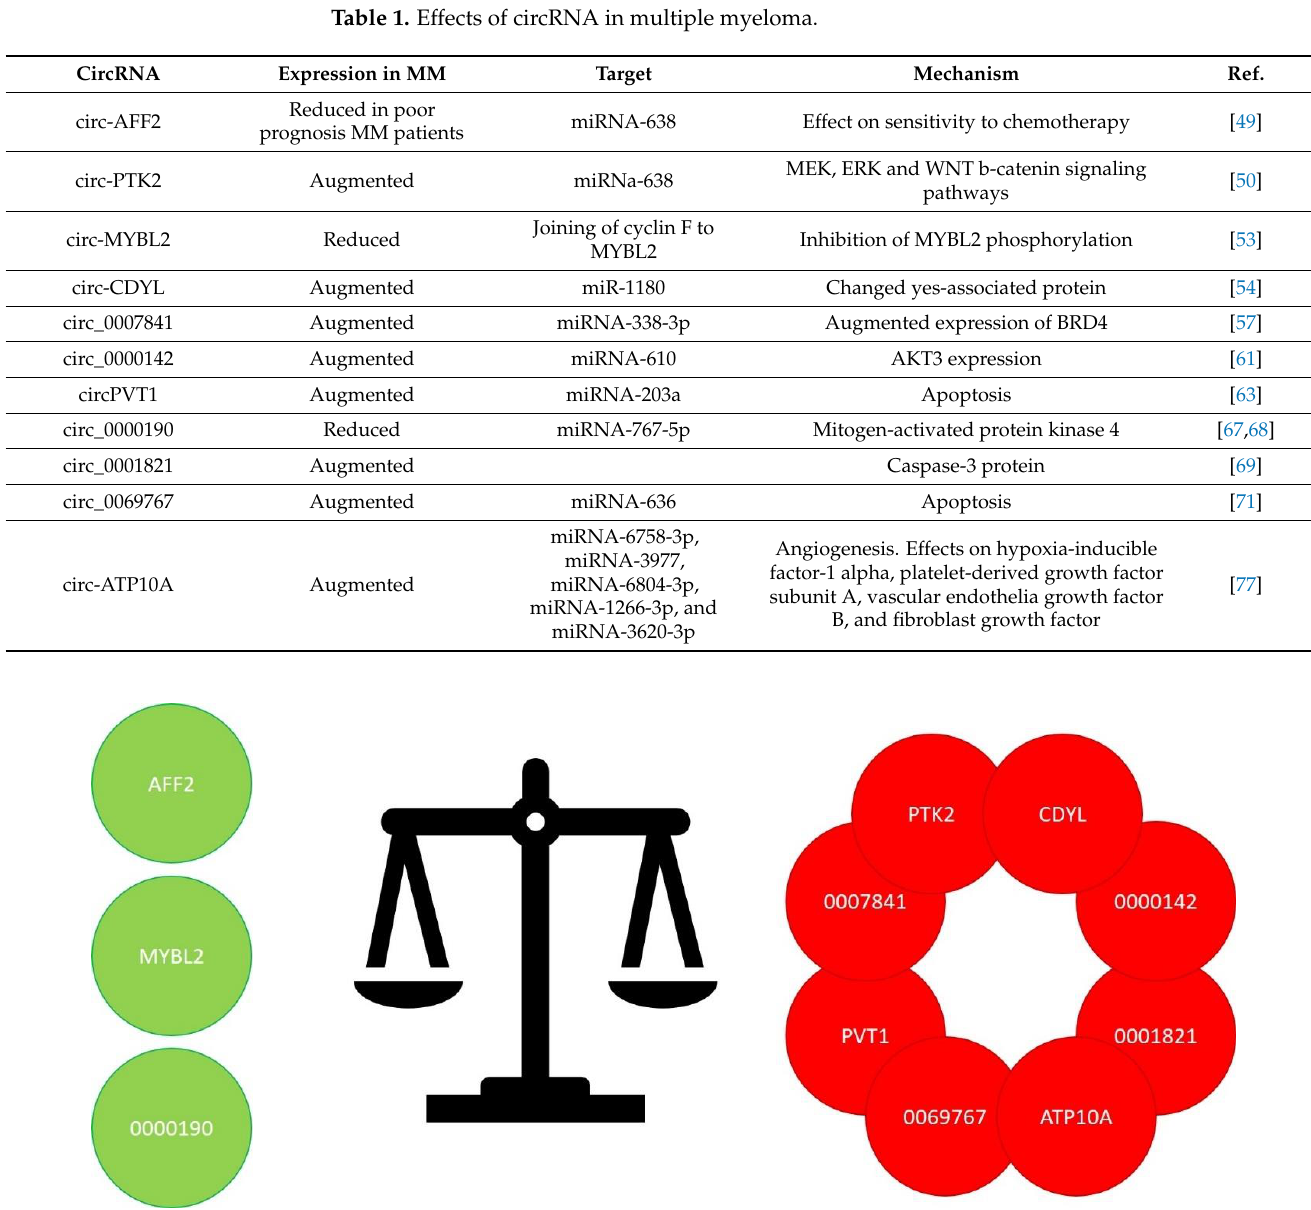
Figure 3. Reduced (green) and increased (red) circRNA in MM.